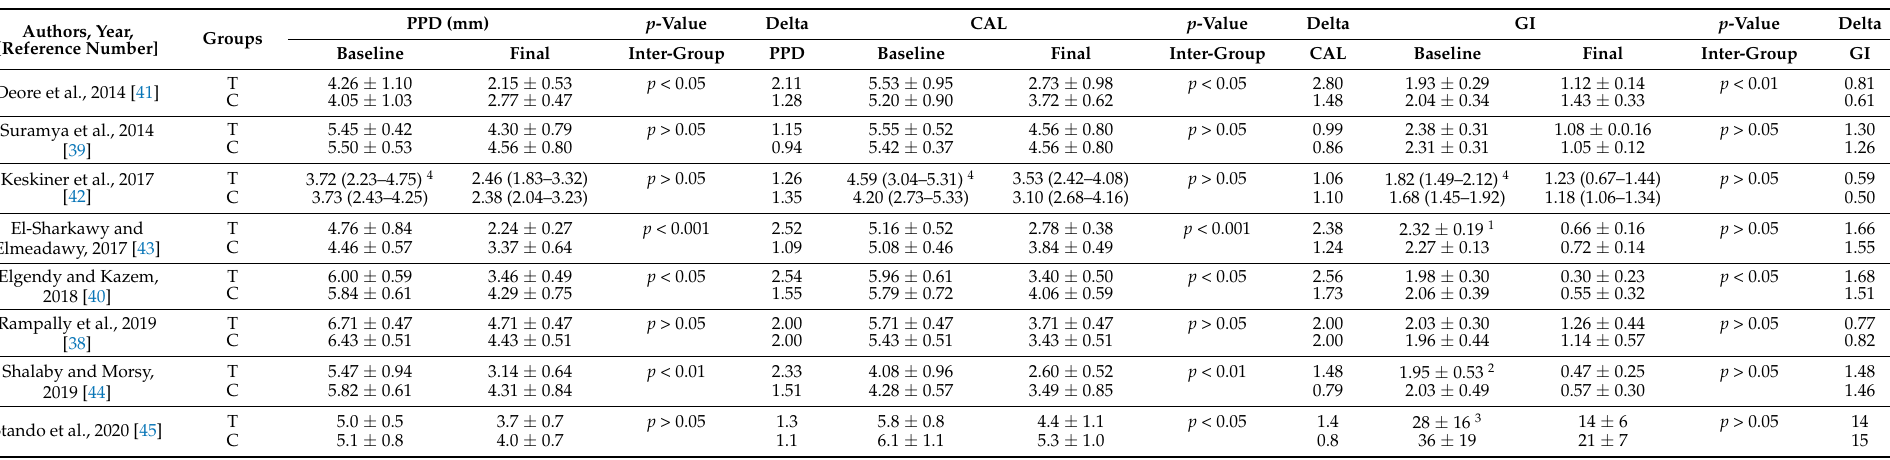
Table 3. Mean values (standard deviation) of clinical periodontal parameters of test and control groups at baseline and final